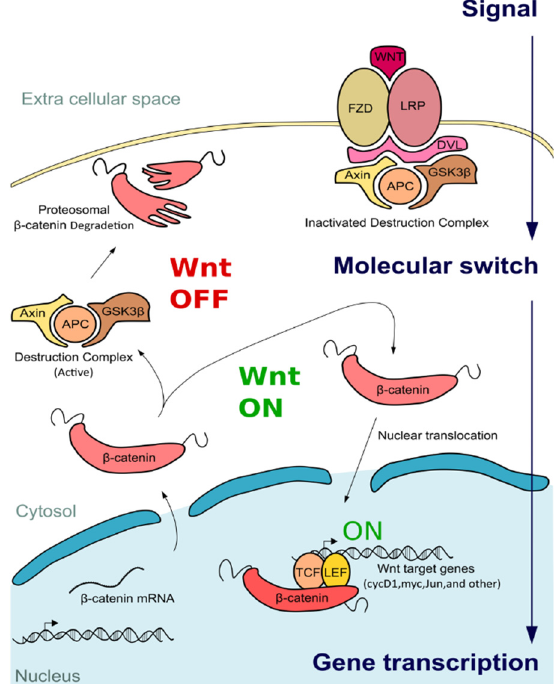
Figure 1. Canonical Wnt signaling cascade. Generally, Wnt signaling is “OFF” since without any stimulus, β -catenin is degraded by the proteasome after phosphorylation mediated by the destruction complex (including Axin1 (Axin), Adenomatous polyposis coli (APC), and the glycogen synthase kinase 3 β (GSK3 β )). Conversely, when Wnt ligands bind to the receptors Frizzled (FZD) and Lipoprotein receptor-related protein 5/6 (LRP), Dishevelled (DvI) is recruited and contributes to the destruction complex inactivation. Consequently, β -catenin is not restricted and can translocate into the nucleus contributing to the activation of the transcription of Wnt-related genes, directly binding the T cell lymphocyte differentiation factors (TCF) and lymphoid enhancer-binding factor 1 (LEF).